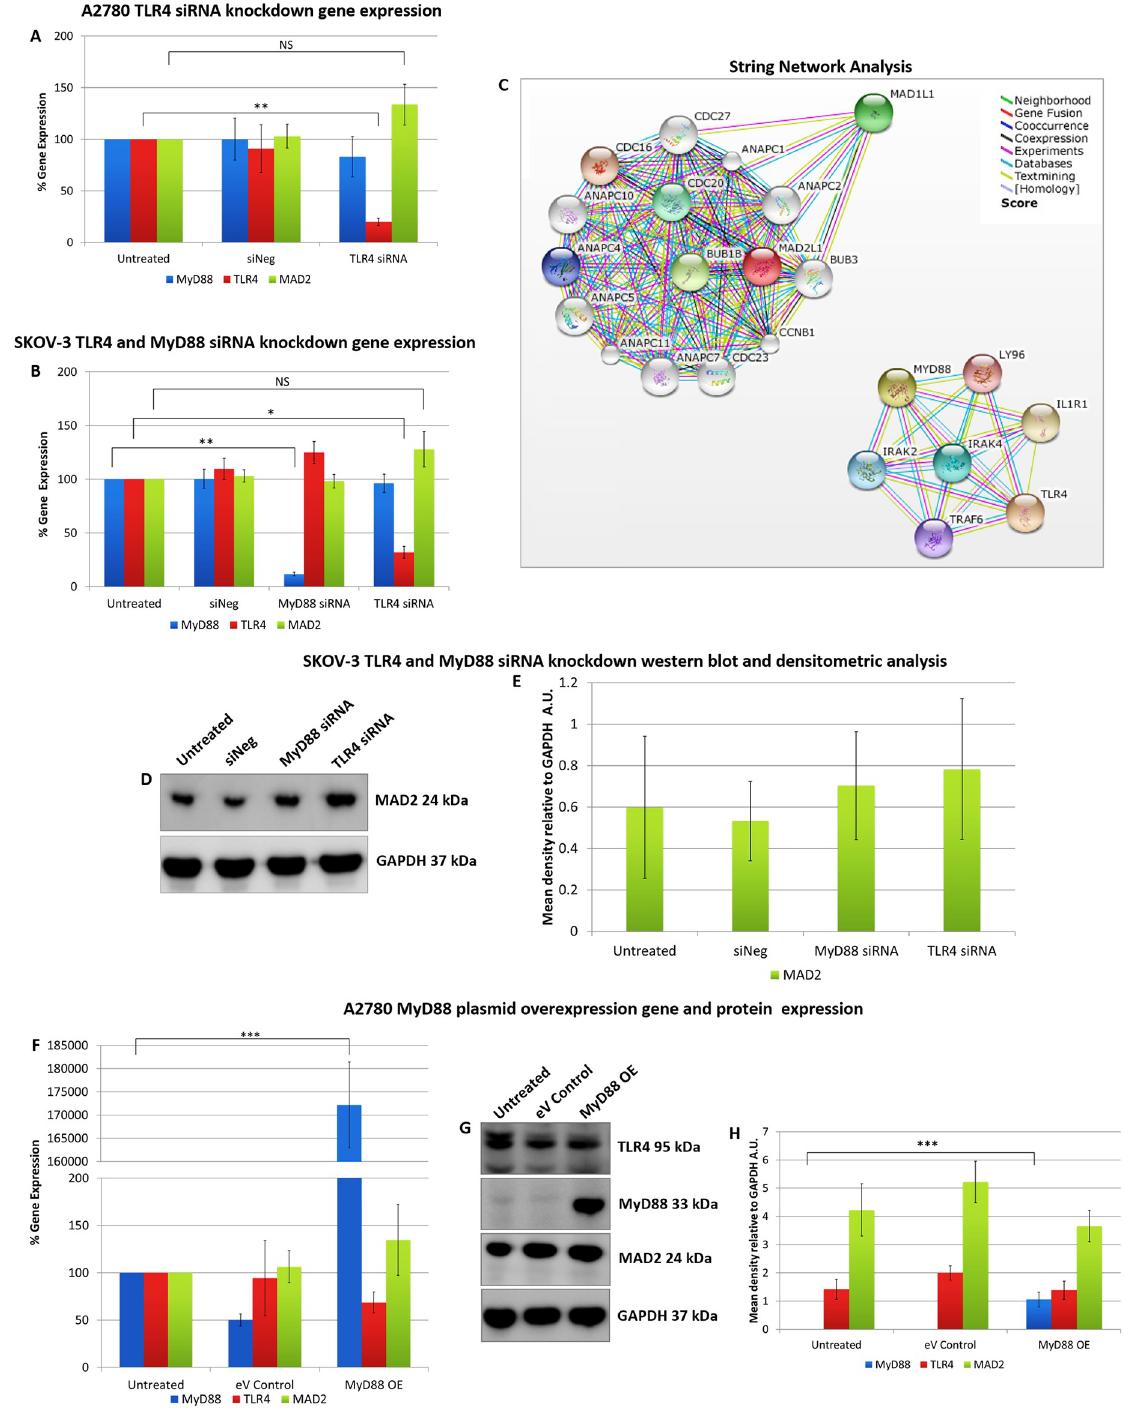
Fig 1. Alteration of TLR4 and MyD88 expression does not alter MAD2 expression in A2780 or SKOV-3 cells. MyD88, TLR4 and MAD2 gene expression levels in (A) A2780 and (B) SKOV-3 cells, 72 hours following transfection with siRNA targeting TLR4 or MyD88. Neither knockdown of TLR4 in both SKOV-3 and A2780 cells or knockdown of MyD88 in SKOV-3 cells had any significant impact on the expression of MAD2. (C) Screenshots from the STRING website, which was queried for relationships between TLR4, MyD88 and MAD2. Coloured lines between the proteins indicate the various types of interaction evidence. In-silico analysis predicted that there was no direct interaction between MAD2 and MyD88 or TLR4. (D) Western blot analysis and (E) densitometric analysis of MAD2 protein expression